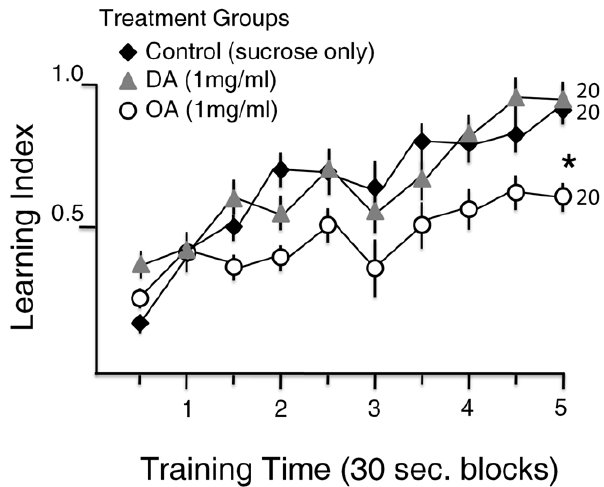
Figure 4. Punishment time during learning. The total time bees were on the shock half of the apparatus during the 5 minute training session is the punishment or ‘‘total time in shock side’’ during learning. Punishment time during learning for groups of bees fed sucrose (Control), or sucrose with treatment chemicals (OA, DA, OA + Mianserin, Pimozide, DA + Pimozide) are shown. There are statistically significant effects of treatment on punishment time during learning (Factorial ANOVA for treatment group effect: F=6.4083, df=5, P , 0.0001). The numbers in the bars indicate the number of individuals in each group. The bars with different letters are statistically significantly different (P , 0.05) from each other in multiple comparisons.